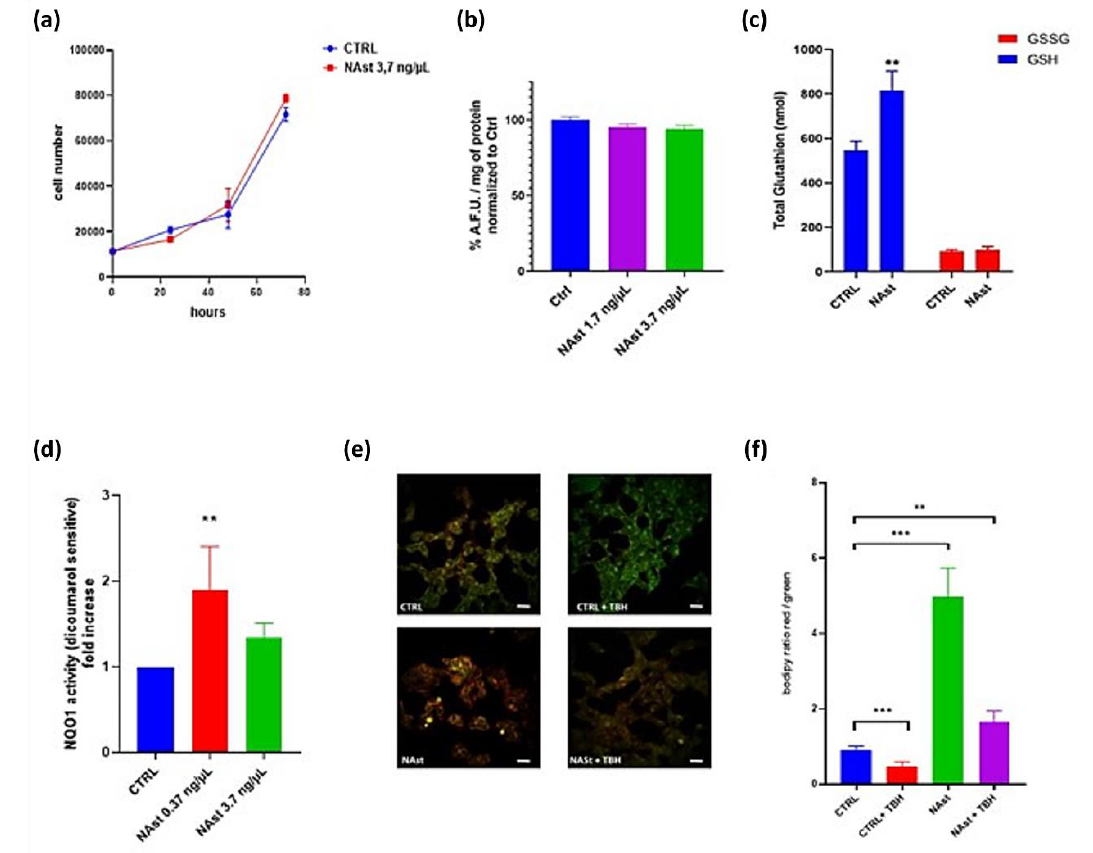
Figure 2. Antioxidant activities of NAst. ( a ) Proliferation of SHSY-5Y cells supplemented with 3.7 ng/ µ L of NAst and synthetic astaxanthin. Cells were counted in triplicate by the Trypan blue exclusion method. Data are reported as cell numbers ± SDs. ( b ) Effects of NAst on intracellular ROS levels in SHSY-5Y cells. Cells were supplemented with different amounts of NAst for 24 h. Intracellular ROS levels were measured in live cells using the probe DCFH-DA by means of spectrofluorimetric analysis. Data are reported as percentages in comparison to controls ± SEMs. ( c ) Total glutathione evaluation in SHSY-5Y cells supplemented with 3.7 ng/ µ L NAst by luminescent assay. Data are shown as the means ± SDs of at least three independent experiments. ** p ≤ 0.01. ( d ) NQO1 activity determination in lysates from SHSY-5Y cells supplemented with NAst for 24 h. Dicoumarol was used to specifically inhibit the enzyme. Data are reported as fold increases in comparison with untreated cells ± SDs; n = 4. ** p ≤ 0.01. ( e ) Representative micrographs of SHSY-5Y cells stained with the lipid peroxidation sensor BODIPY C11. Cells were supplemented with 3.7 ng/ µ L of NAst for 24 h. Oxidative stress was induced using 130 µ M of TBH for 30 min. Scale bars: 10 µ m. ( f ) Quantitative analysis of the red/green BODIPY C11 fluorescence ratio performed using ImageJ software. Five randomly chosen fields were analyzed for each condition. Error bars indicate SDs. ** p ≤ 0.01, *** p ≤